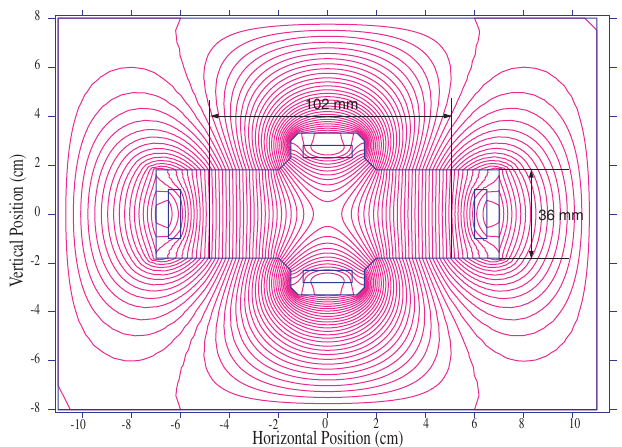
FIG. 14. (Color) Cross-sectional view of the PQM with mag- netic field lines calculated by the two-dimensional code POISSON . The horizontal and vertical gaps are 102 and 36 mm, respec- tively. The maximum field strength at a current of 2000 A is about 0.2 T at the locations near upper and lower